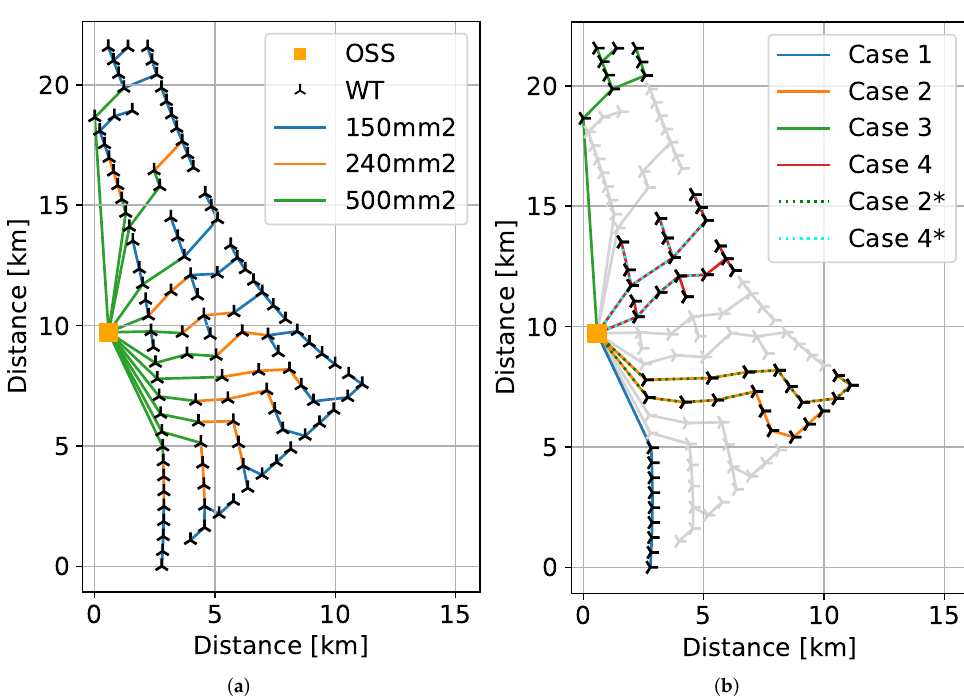
Figure 4. Anholt Wind Farm collector system layout and case designated layouts. ( a ) Collector system layout. ( b ) Case studies.